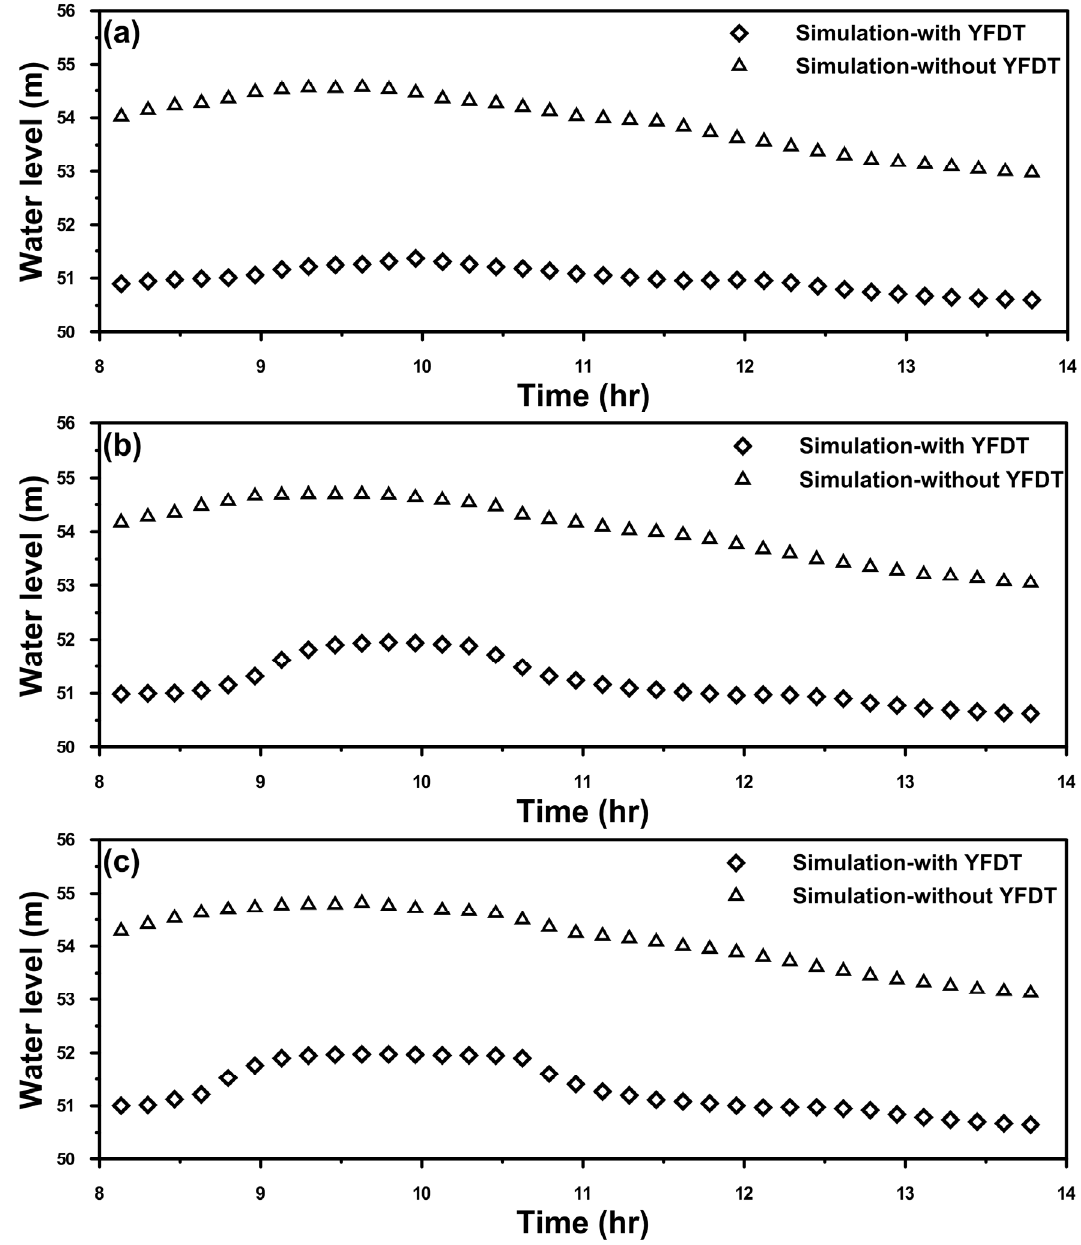
Figure 8. Comparison of time-series water levels at the Ruifang Bridge with and without the Yuansantze flood diversion tunnel (YFDT) for the following return periods: ( a ) 50-year; ( b ) 100-year; and ( c )